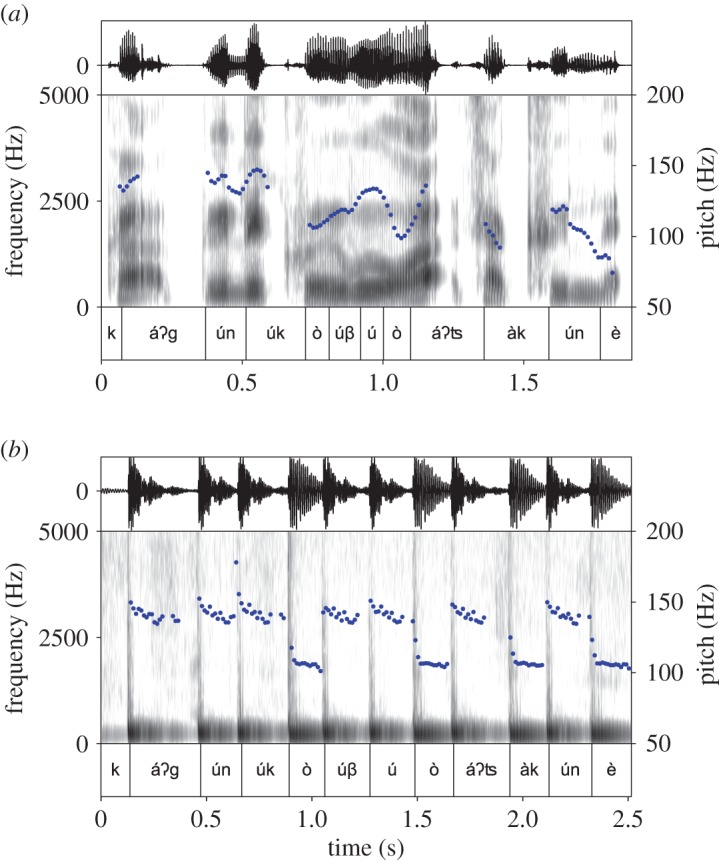
Acoustic properties of the Bora phrase káʔgúnúkòúβú ò áʔʦàkúnè ‘I am finishing the cahuana (manioc starch drink)’, in spoken (a) and drummed (b) versions. Oscillograms (top rows of a and b) represent acoustic energy as sound pressure over time. Spectrograms (middle rows) represent the spectrum of frequencies that is interpretable as linguistically distinctive acoustic information. Blue dotted lines indicate pitch. Bottom rows provide transcription and segmentation into vowel-to-vowel intervals (see the text for explanation). Figure created in PRAAT [65]. Corresponding sound files are provided in electronic supplementary material, S3 and S4.